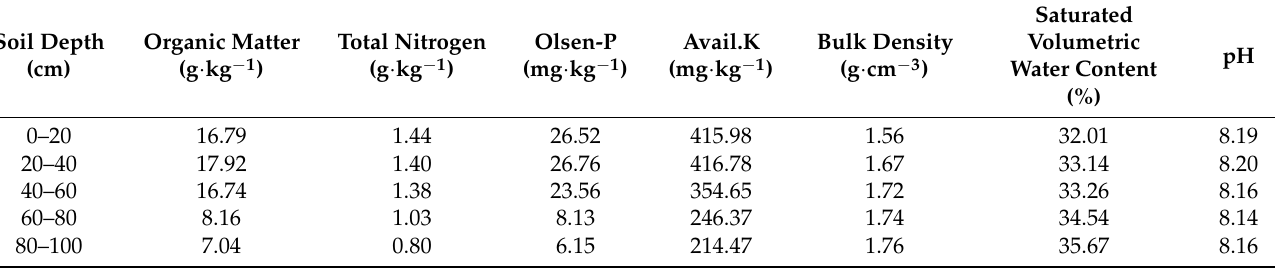
Table 1. The physicochemical properties of soil in the station.